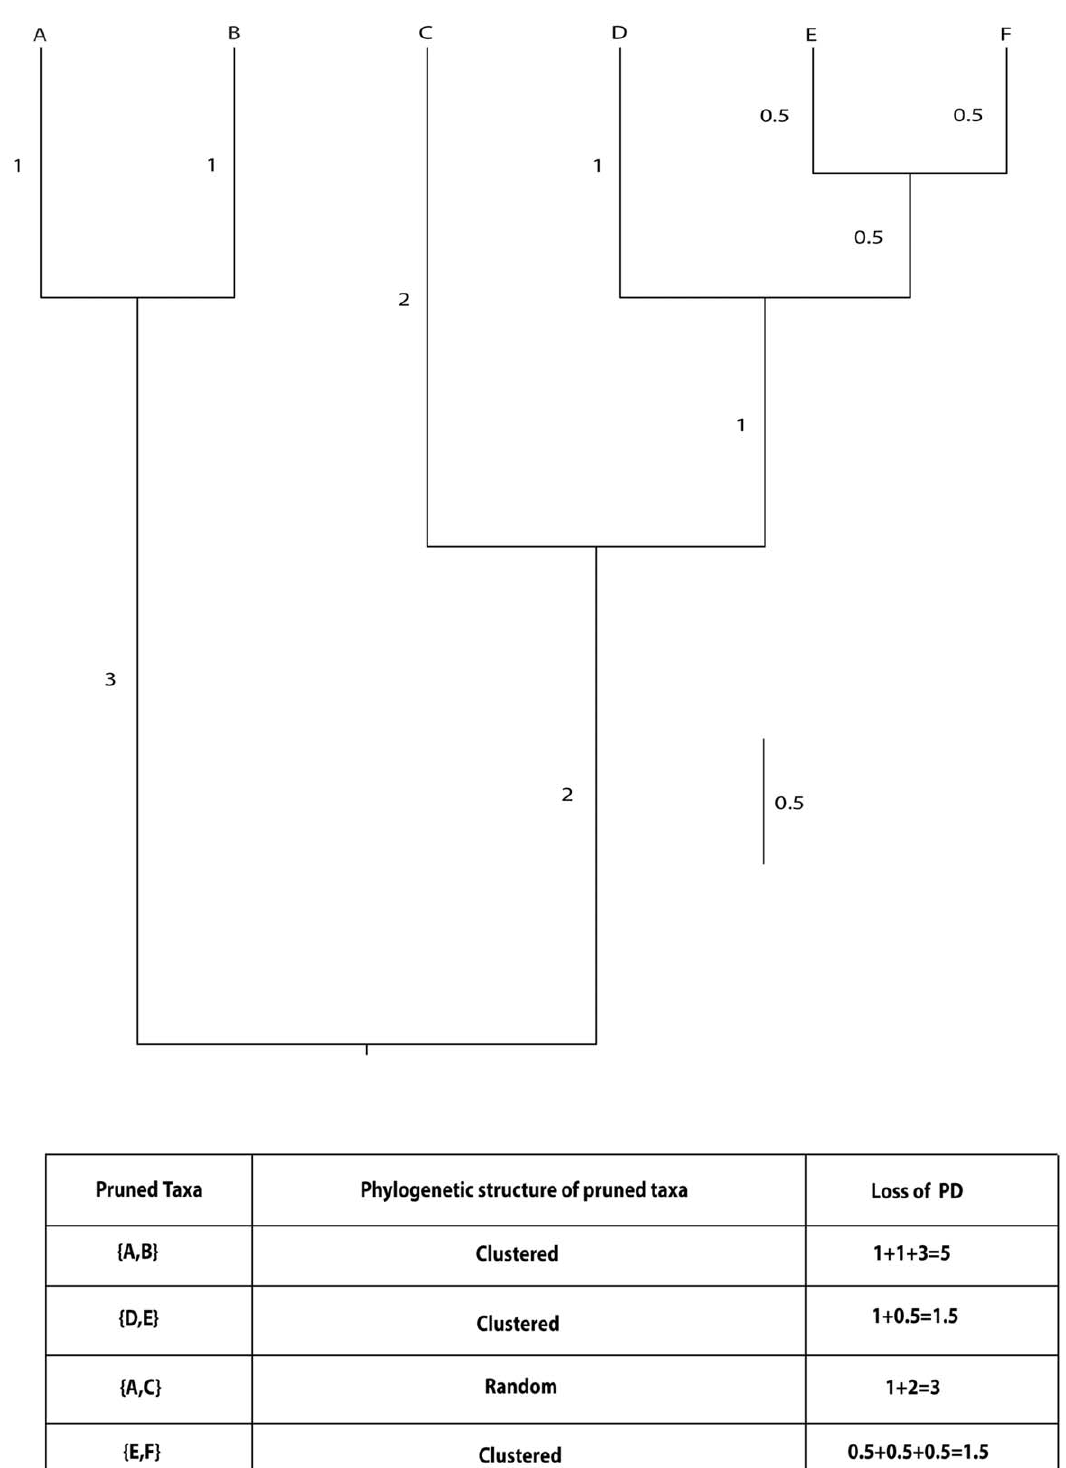
Figure 1. Observed PD loss on a tree. A cartoon tree of size n=6, showing how losing different pairs of species lead to different PD loss. For this tree, total PD =12.5.